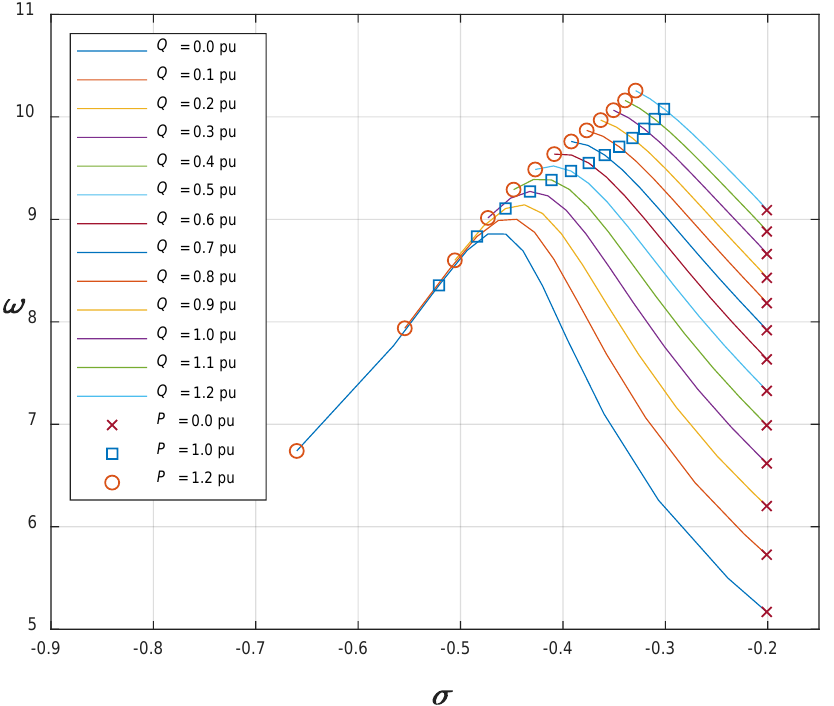
Figure 7. Eigenvalue loci of local mode of 911-MVA turbo-type synchronous generator without AVR.